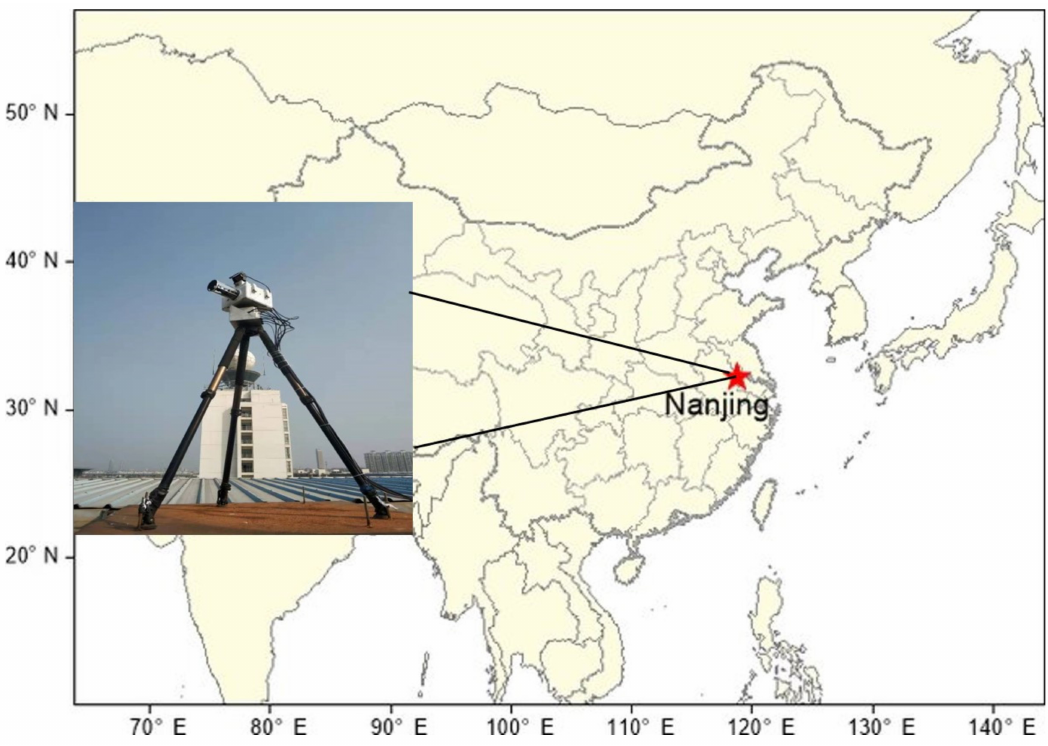
Figure 1. MAX-DOAS observation site at Nanjing University of Information Science and Technology, Pukou district,